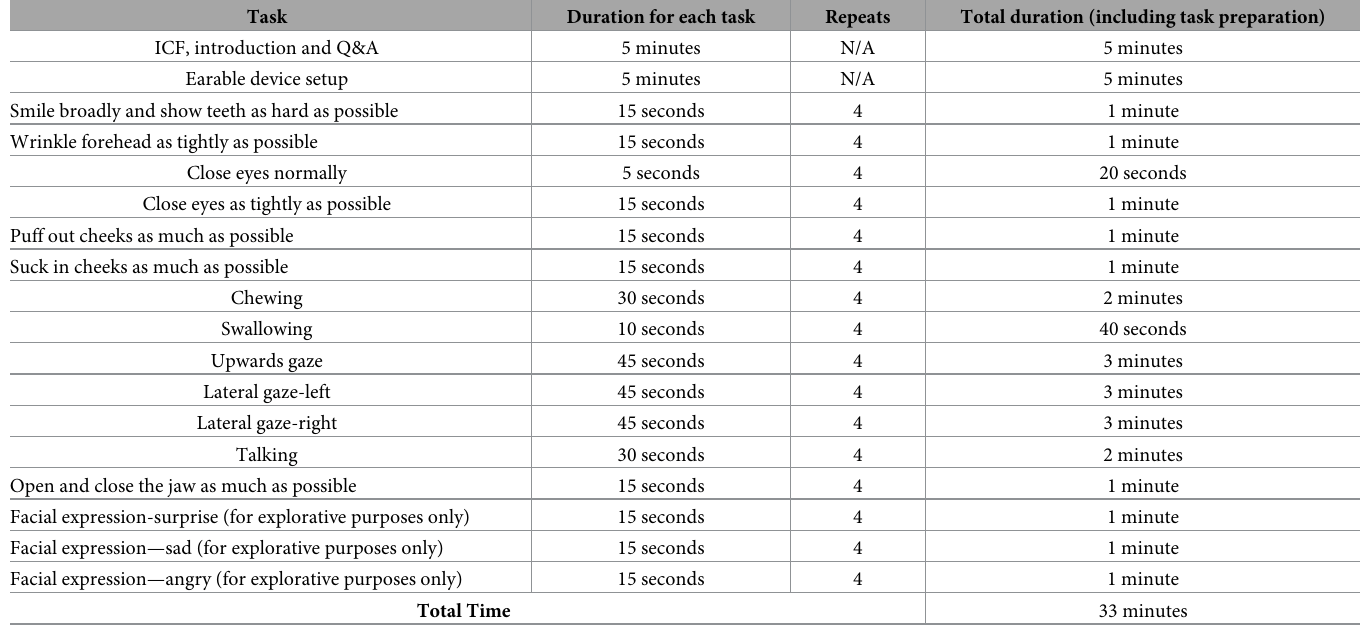
Table 3. Tasks and duration of each task study session. Task Duration for each